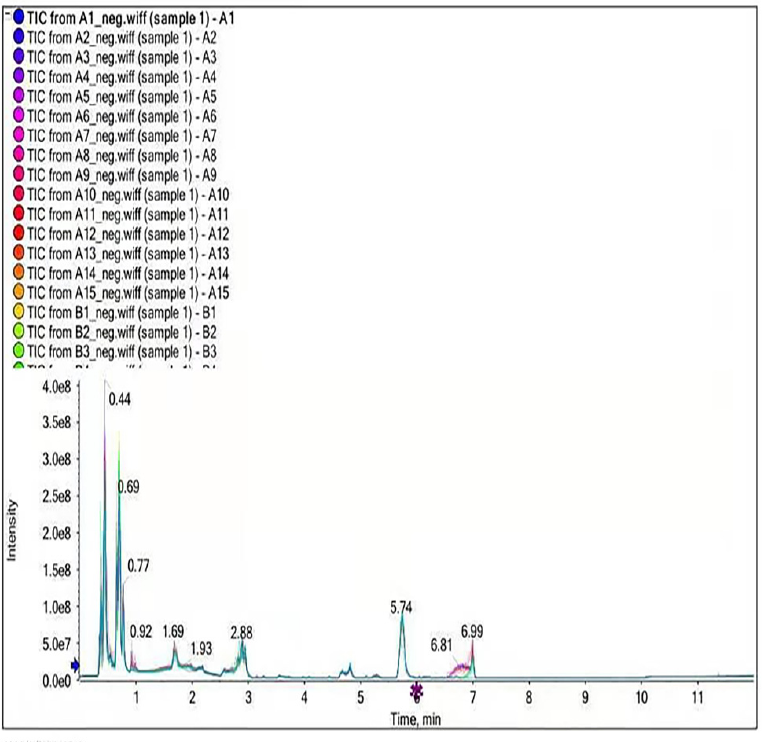
2 Figure 2. Total ion current diagram in negative ion